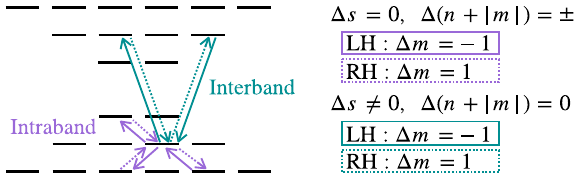
Figure 2: TQD selection rules: E1 selection rules for TQD state | | − , 1 , 1 ∕ 2 ⟩ . Interband (green) transitions couple energy levels above and below the Dirac point. Intraband (purple) transitions couple levels within the same section of the Dirac cone. Both left-hand (solid arrows) and right-hand (dotted arrows) polarised light facilitate